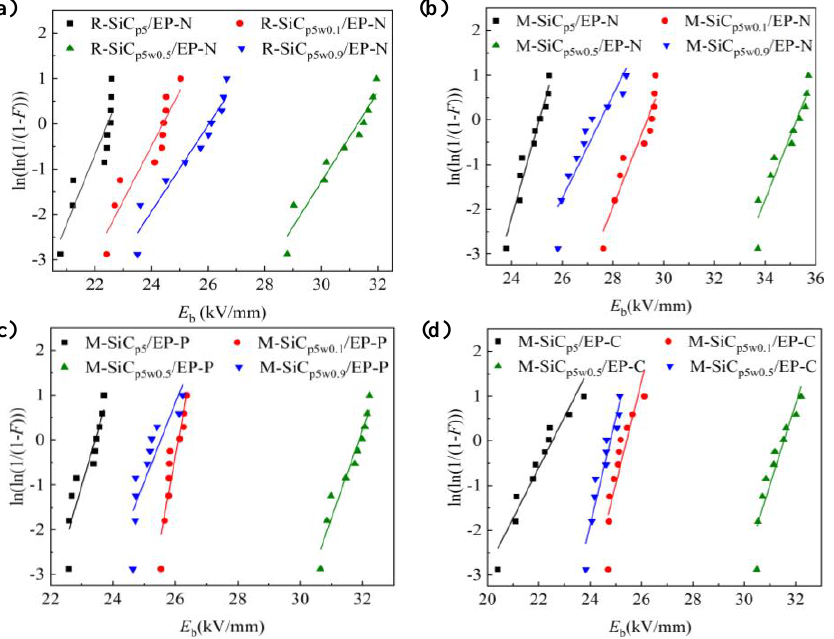
Figure 8. Weibull distribution of the breakdown strength of composites with same type and different components. ( a ) R-SiC/EP-N; ( b ) M-SiC/EP-N; ( c ) M-SiC/EP-P; ( d ) M-SiC/EP-C.